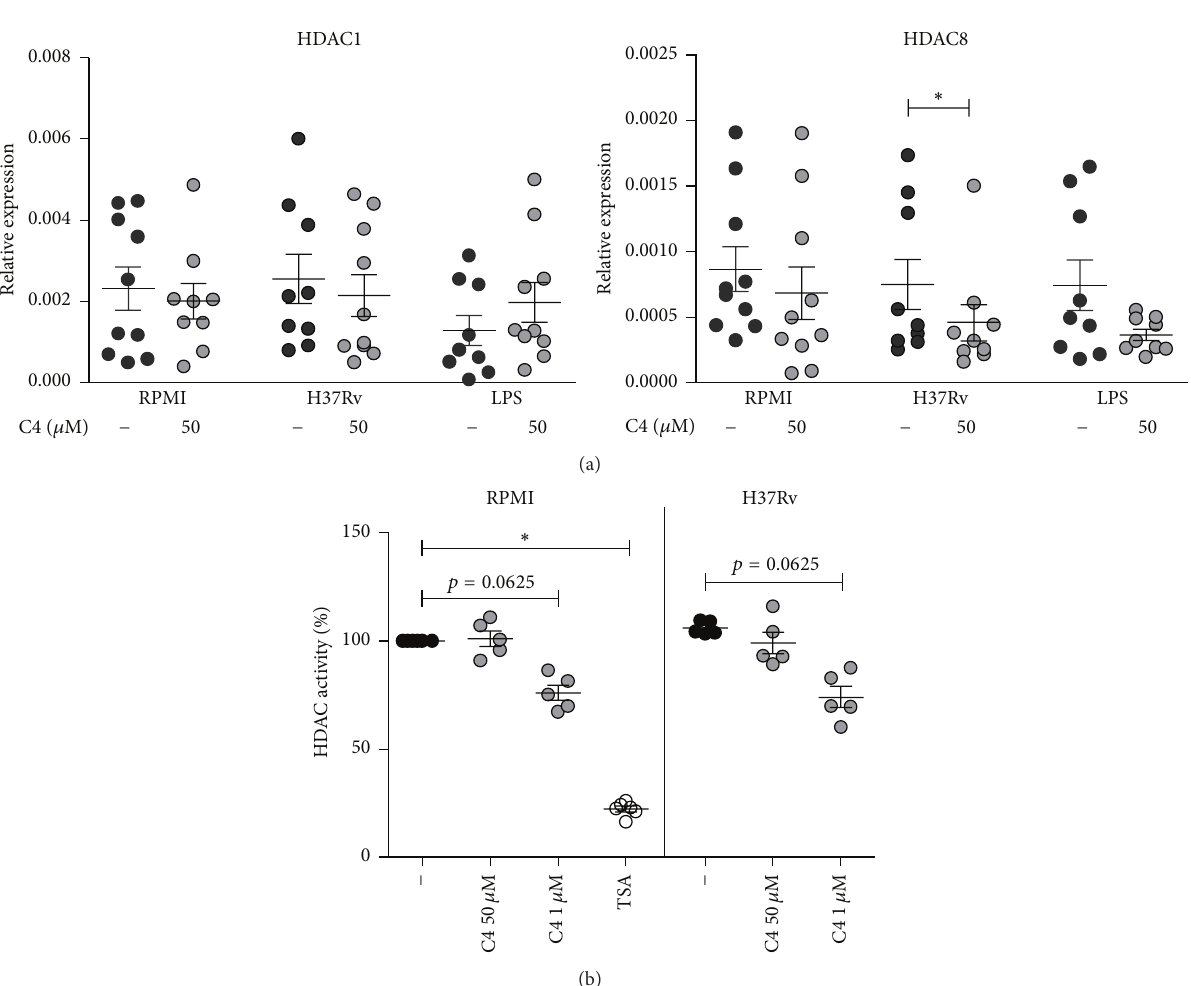
Figure 2: Influence of butyrate on HDAC expression and activity. (a) PBMCs were preincubated with 50 𝜇 M C4 for 1 h prior to stimulation with Mtb lysate or LPS for 4h. Gene expression levels of HDAC1 and HDAC8 were measured by qPCR. Data are means ± SEM ( 𝑛 = 10 ), using Wilcoxon signed-rank test, representative of 3 independent experiments. ∗ 𝑝 < 0.05 . (b) Percentage of general HDAC activity relative to RPMI stimulated PBMCs, as measured by levels of substrate deacetylation after 30 min of preincubation with C4 (50 𝜇 M) and 30 min of stimulation with Mtb lysate. Data are means ± SEM ( 𝑛 = 5 to 6), using Wilcoxon signed-rank test, representative of 3 independent experiments. ∗ 𝑝 < 0.05